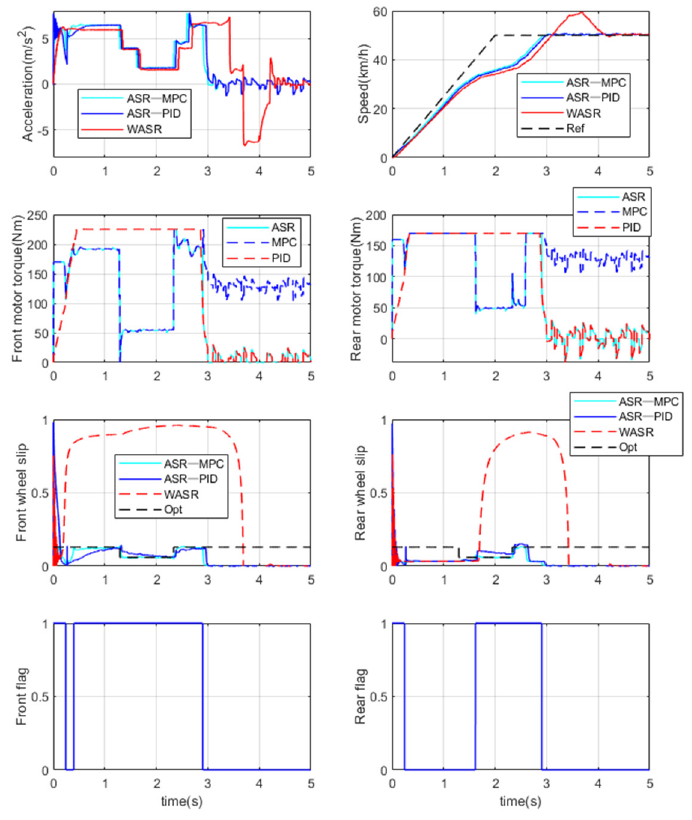
Figure 10. Vehicle starts on a docking road.